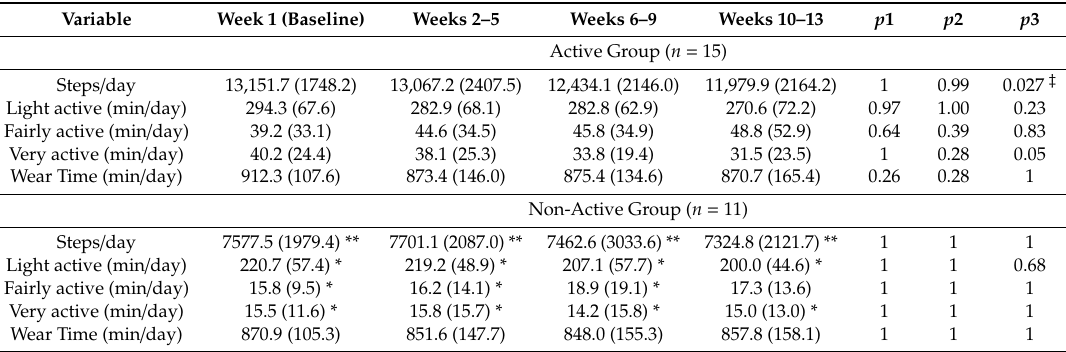
Table 2. Physical activity data registered by Fitbit Charge HR during the 13-week